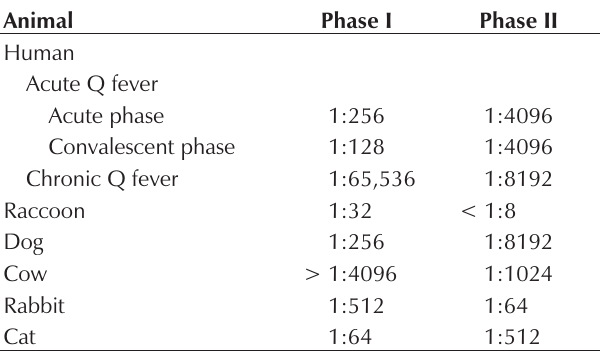
TABLE 1 Antibody titres to phase I and phase II Coxiella burnetii anti- gens, by indirect immunofluorescence antibody test, of the sera from the various animals Animal Phase I Phase